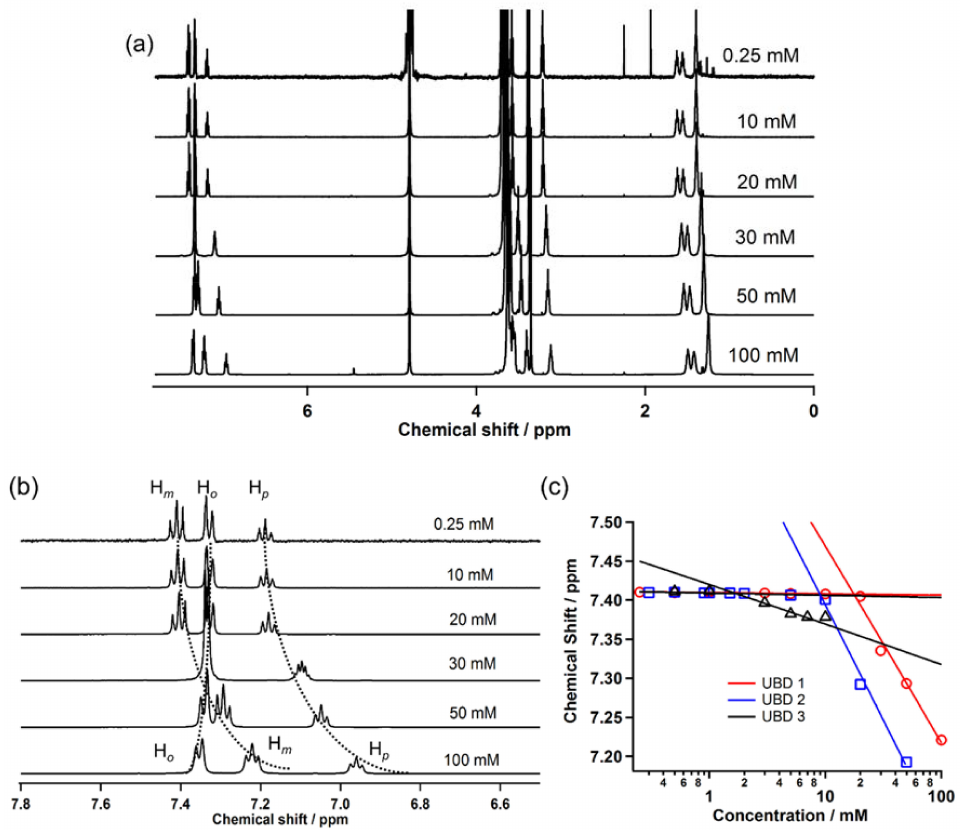
Figure 1. 1 H NMR spectral changes with concentration of UBD-1 . ( a ) 1 H NMR spectra in the chemical shift region of 0.0–7.8 ppm; and ( b ) enlarged aromatic region; ( c ) Plots of the H m chemical shift as a function of the concentration for UBD-1 – 3 . H m indicates the aromatic protons in the meta position (Scheme